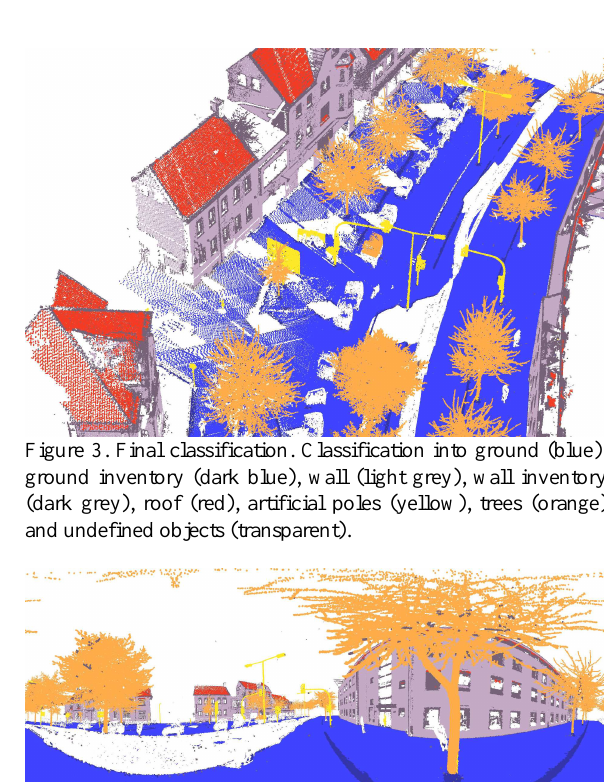
Table 7. Error matrix of the classification accuracies